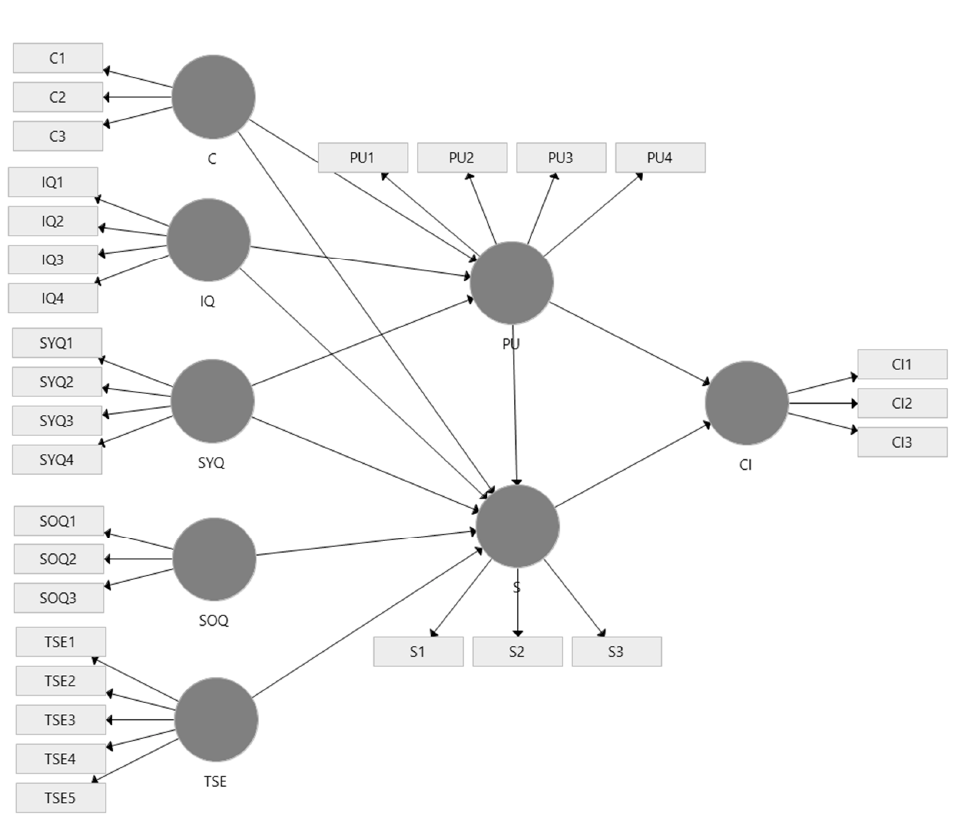
Figure 3. Path Diagram of The Conceptual Model.